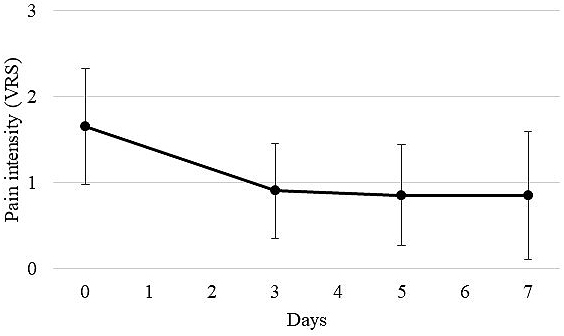
Change in mean pain scores on verbal rating scale (VRS).VRS scores were determined before and on days 3, 5, and 7 after methadone administration. Numerical rating scale (NRS) scores were converted to VRS scores as follows: NRS 0 = no pain (VRS 0), NRS 1-4 = mild pain (VRS 1), NRS > 4-7 = moderate pain (VRS 2), and NRS > 7-10 = severe pain (VRS 3).